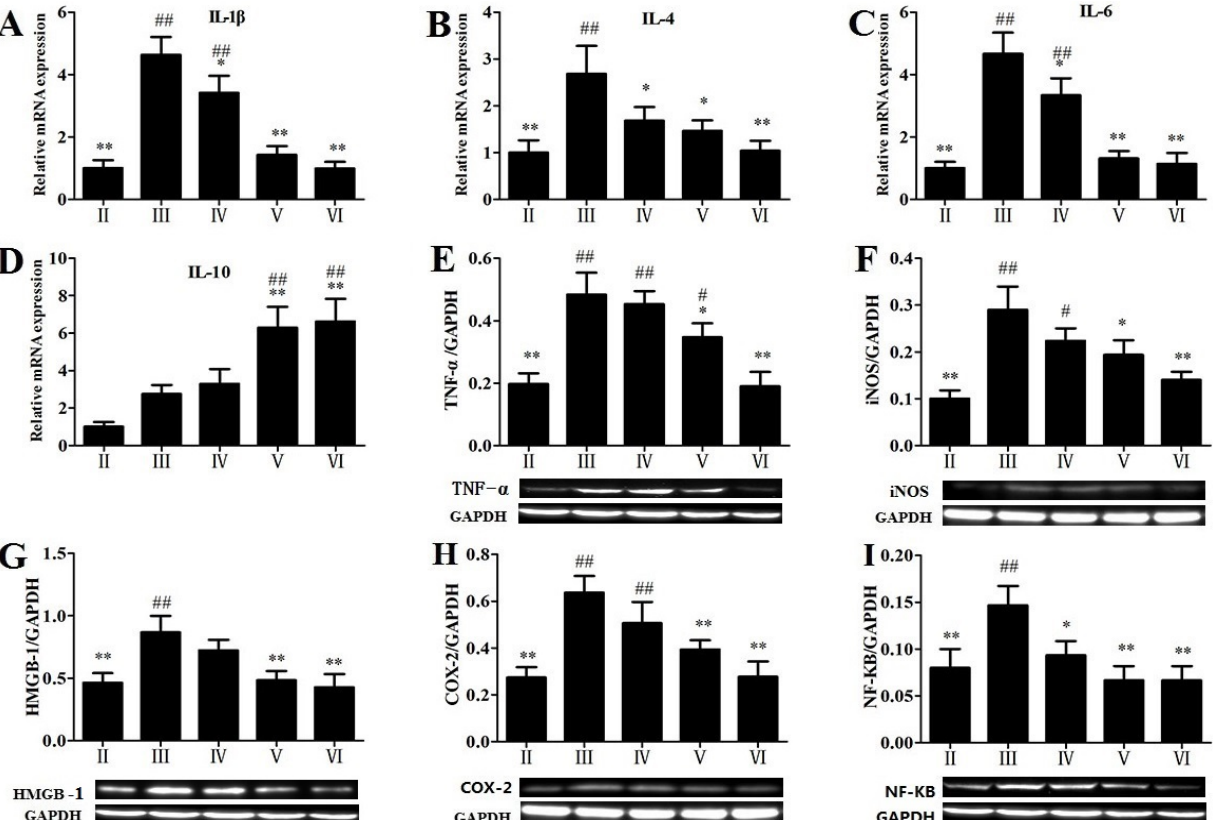
Figure 5. Effects of RLTS on the gene expressions of IL-1 β ( A ), IL-4 ( B ), IL-6 ( C ), IL-10 ( D ), and the protein expressions of TNF- α ( E ), iNOS ( F ), HMGB-1 ( G ), COX-2 ( H ), NF- κ B ( I ). Values are expressed as mean ± SD ( n = 4). * p < 0.05, ** p < 0.01 vs. model group; ## p < 0.01, # p < 0.05 vs. normal